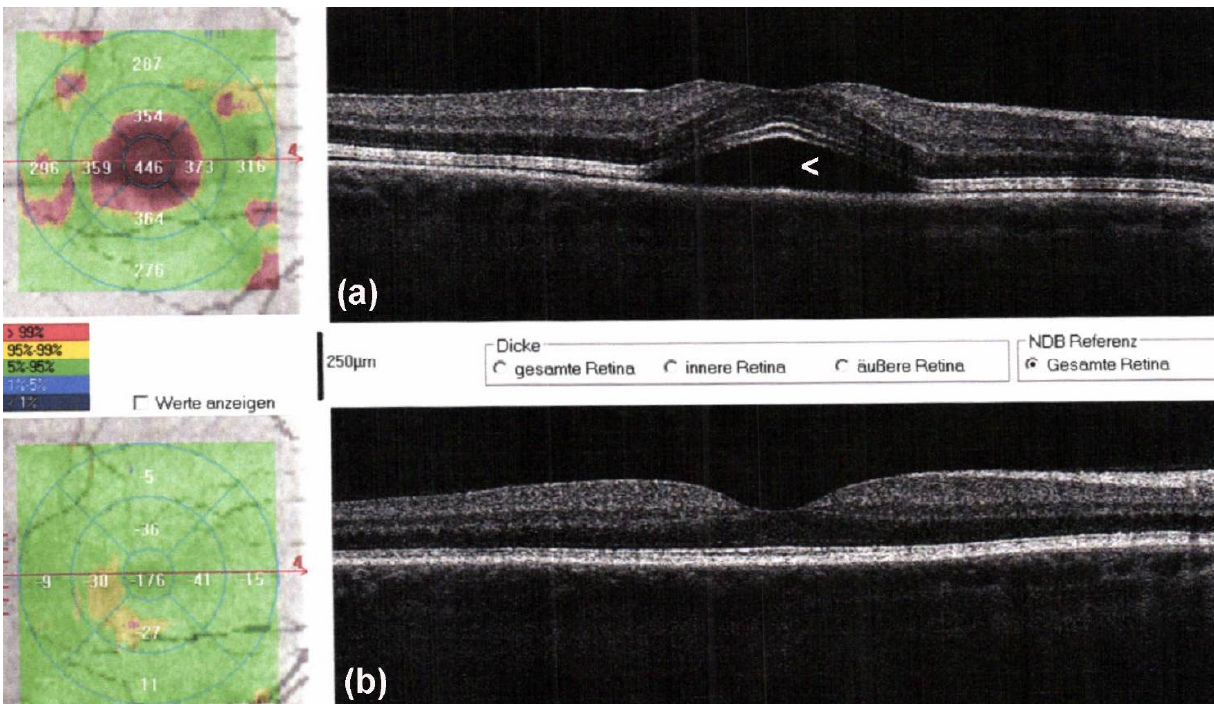
Figure 5. Optical coherence tomography (OCT) scans of a male patient with metastatic melanoma started targeted therapy with encorafenib and binimetinib. Two days after therapy initiation, he noticed blurry vision. On OCT, serous retinal detachment with subfoveolar fluid ( a , arrowhead) is observed, which spontaneously resolved after withholding targeted therapy for 5 days ( b ).